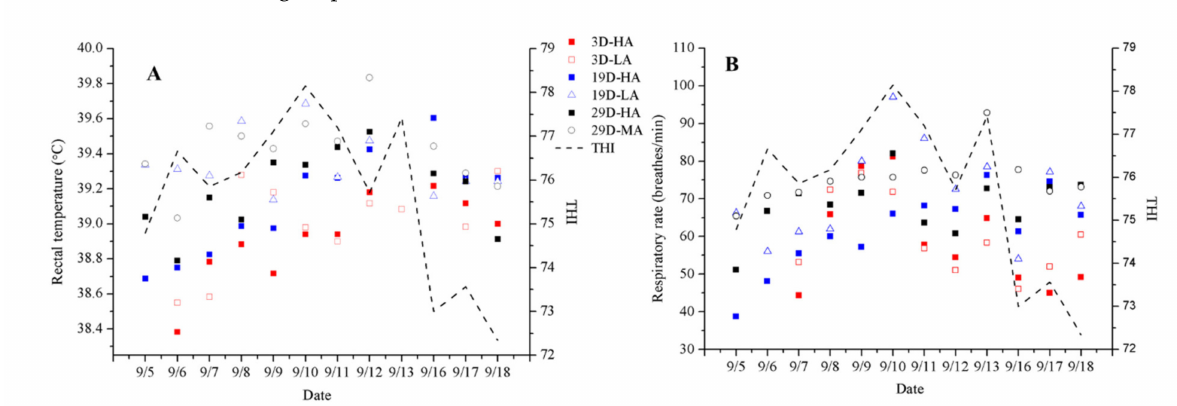
Figure 3. Daily changes (mean ± SEM) of rectal temperature ( A ) and respiratory rate ( B ) with average daily THI of groups 3D-HA, 3D-LA, 19D-HA (19 ( ± 3)-day-olds who received high-speed airflow), 19D-LA (19 ( ± 3)-day-olds who received low-speed airflow), 29D-HA (29 ( ± 3)-day-olds who received high-speed airflow), and 29D-MA (29 ( ± 3)-day-olds who received medium-speed airflow). THI is the temperature and humidity index.